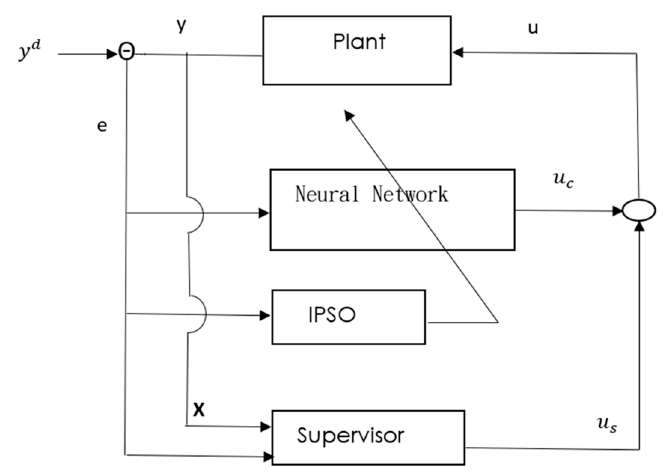
Figure 15. The overall scheme of stable IPSO-based